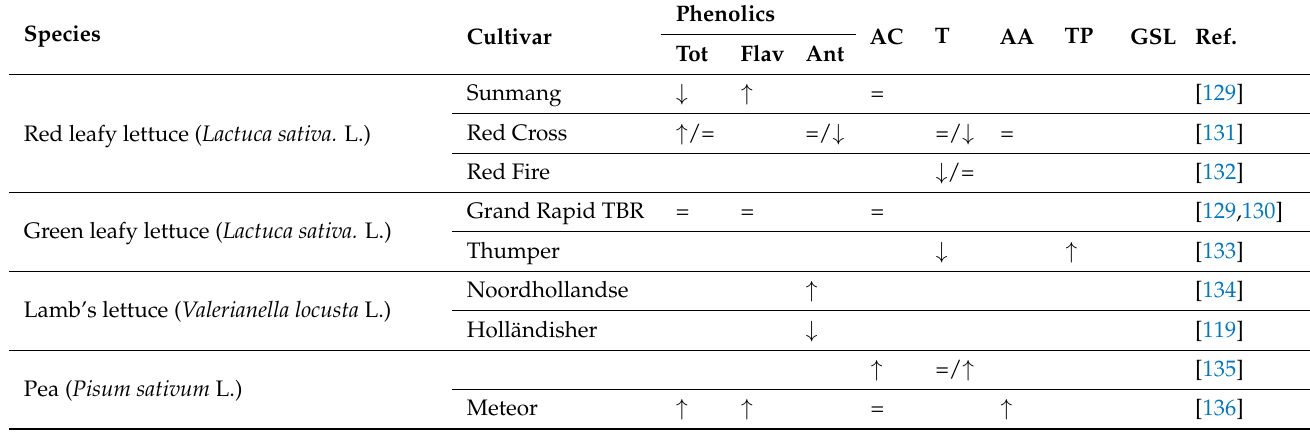
Table 1. Biochemical responses of crops and plants of food interest to red and far-red light wavelengths considered in this review. Tot, total phenolics; Flav, flavonoids; Ant, anthocyanins; AC, antioxidant capacity; T, terpenoids; AA, ascorbic acid; TP, tocopherols; GSL, glucosinolates. For each plant species and cultivar, and for each secondary metabolite or metabolic class considered, the symbols “ ↓ ”, “ ↑ ” and “=” mean a decrease, increase or no variations, respectively, compared to the control plants of each study. Phenolics Species Cultivar AC T AA TP GSL Ref. Tot Flav Ant Sunmang ↓ ↑ = [129] Red Cross ↑ /= =/ ↓ =/ ↓ = [131] Red leafy lettuce ( Lactuca sativa. L.) Red Fire ↓ /= [132] Grand Rapid TBR = = = [129,130] Green leafy lettuce ( Lactuca sativa. L.) Thumper ↓ ↑ [133] Noordhollandse ↑ [134] Lamb’s lettuce ( Valerianella locusta L.) Holländisher ↓ [119] ↑ =/ ↑ [135] Pea ( Pisum sativum L.) Meteor ↑ ↑ = ↑